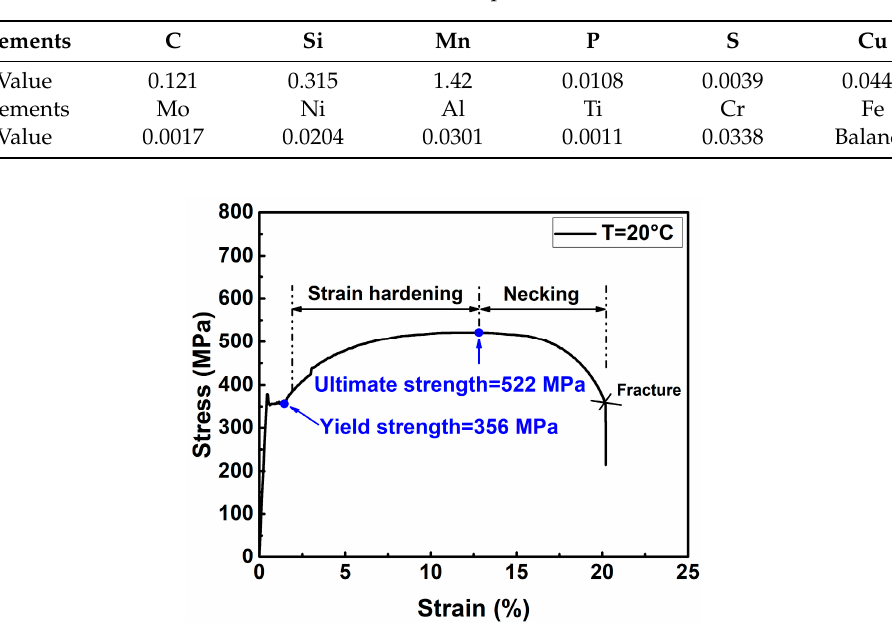
Table 1. Measured chemical composition of S355N steel.